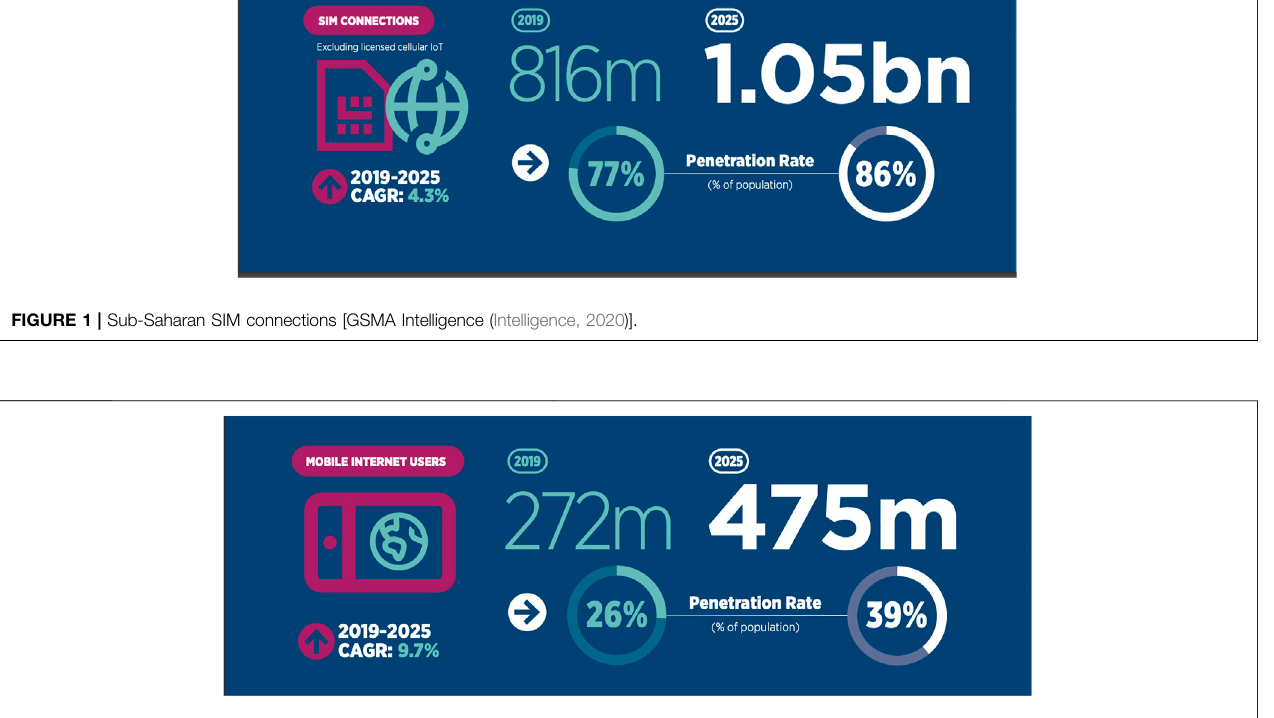
FIGURE 2 | Sub-Saharan mobile network users [GSMA Intelligence